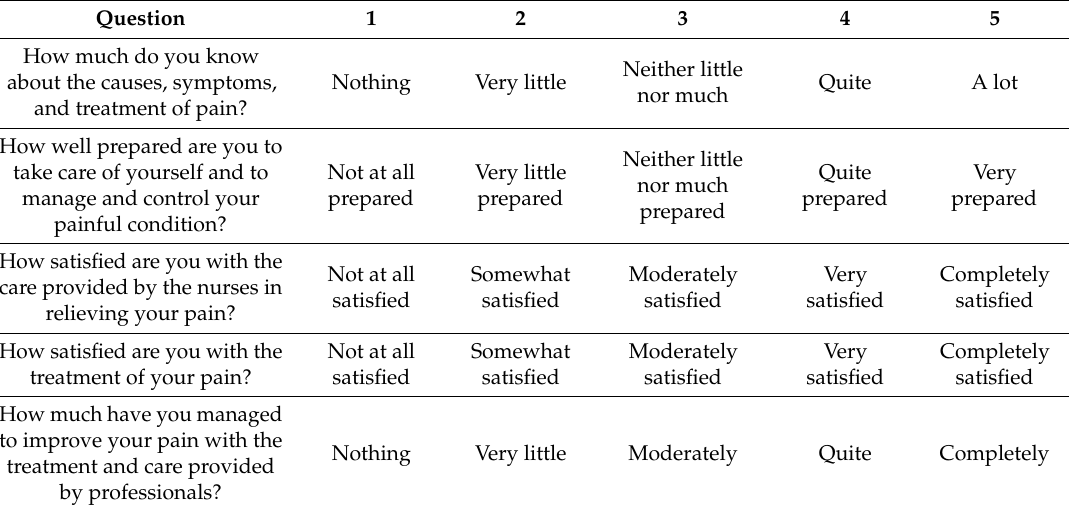
Table 1. Questions to patients about their